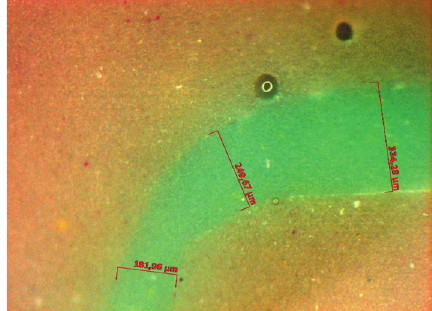
Figure 3: Film measurement held in stereomicroscope.